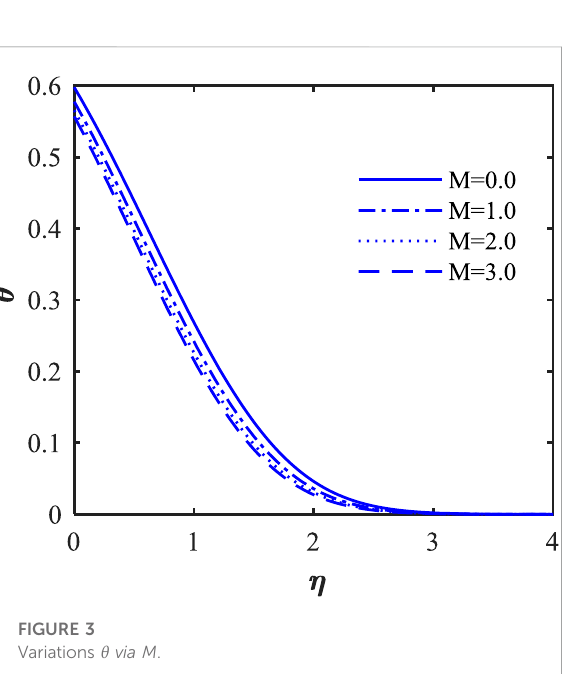
FIGURE 5 Variations of f ′ via λ .